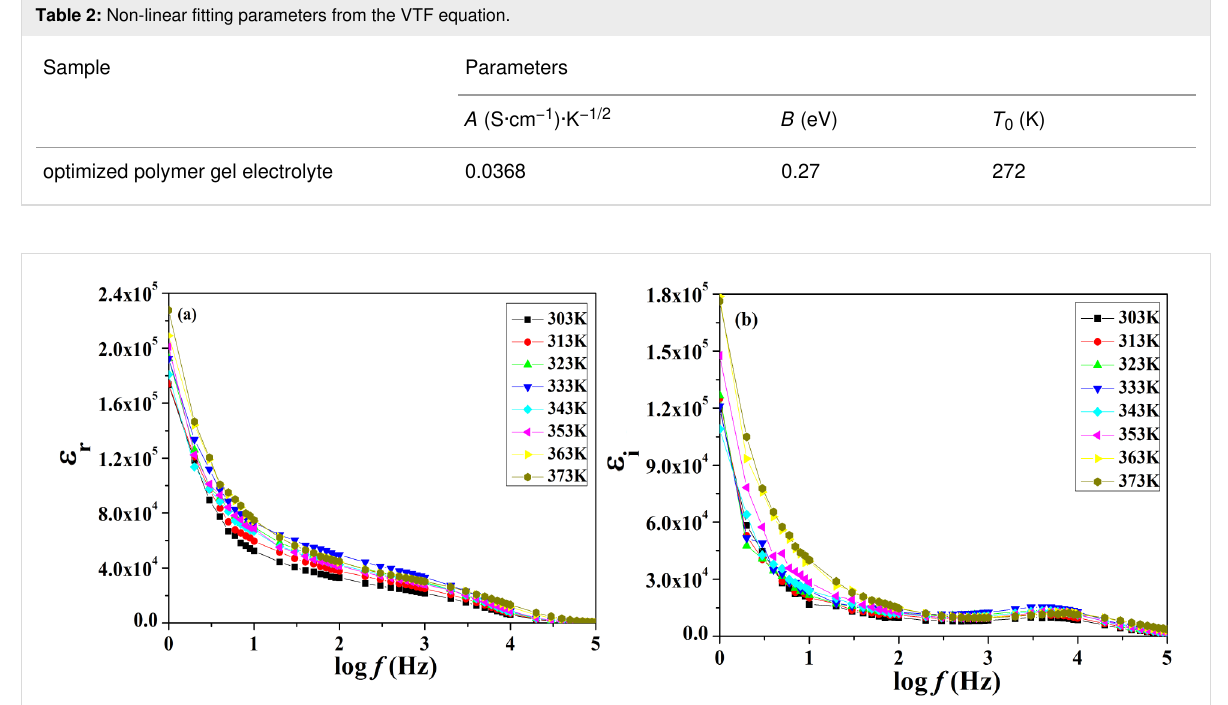
Figure 6: (a) Variation of the dielectric constant of a polymer gel electrolyte system as a function of frequency at various temperatures. (b) Variation of the dielectric loss of a polymer gel electrolyte system as a function of frequency at various temperatures.